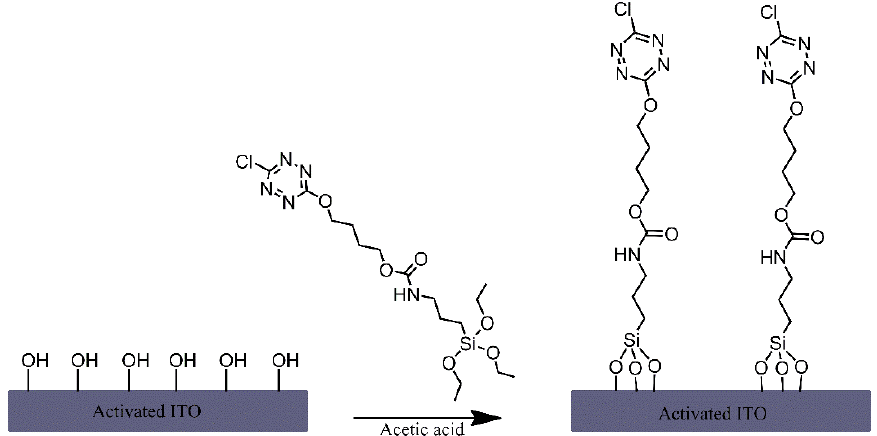
Figure 4. Formation of tetrazine terminated alkyl chain monolayers on indium-tin oxide (ITO). Based on Ref. [1].